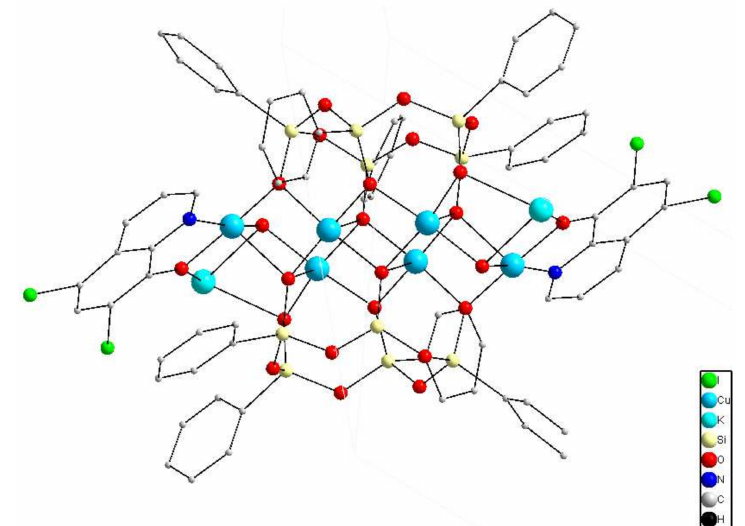
Figure 8. The molecular structure of 9 .